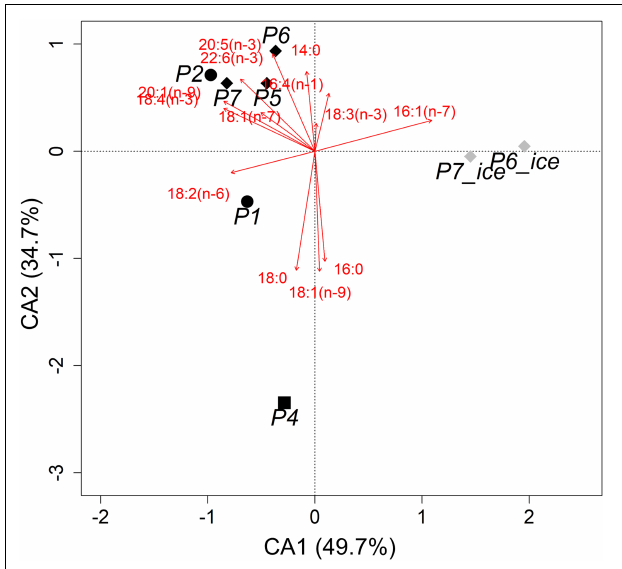
FIGURE 2 | Contribution biplot of correspondence analysis (CA) of fatty acids ( ≥ 1% to the total FA content) in pelagic particulate organic matter (PPOM; black symbols) and ice-associated POM (IPOM; gray symbols) collected during Nansen Legacy cruise Q3 in August 2019 in the Barents Sea. Shapes represent sampling locations with different sea-ice concentrations (P1 and P2: ice-free; P4: close to ice edge; P5, P6, and P7: ice-covered).